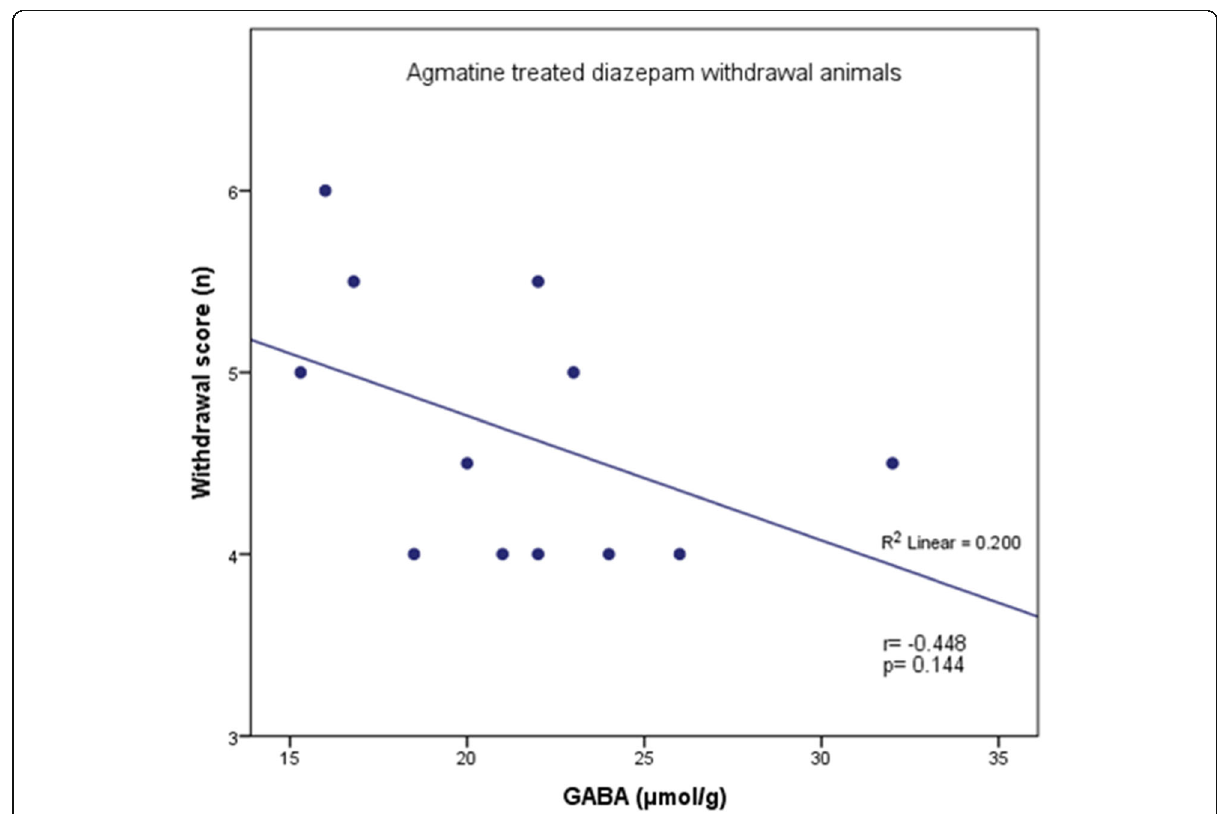
Fig. 9 Correlation between GABA levels and withdrawal score in agmatine-treated diazepam withdrawal